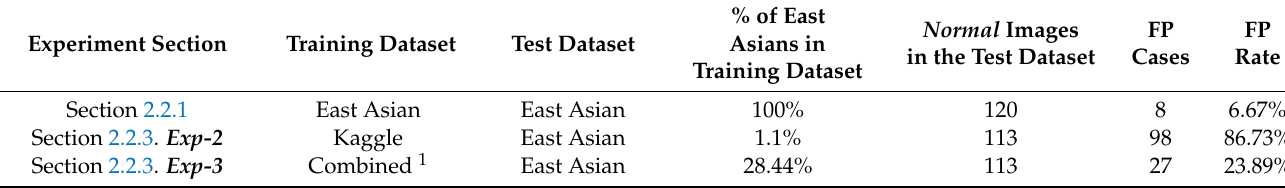
Table 11. FP rates for each of the experiments with the same deep-learning architecture in Figure 4.